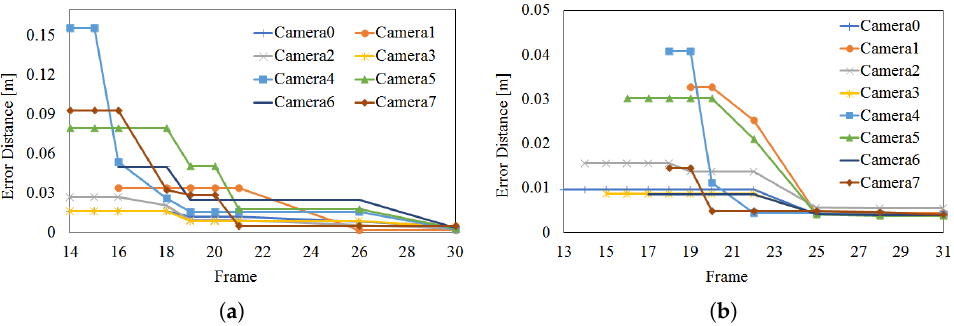
Figure 10. Optimization result of camera parameter based on joints of human 3D joint set ( a ) SDK of Azure Kinect, ( b ) deep learning model of MediaPipe.